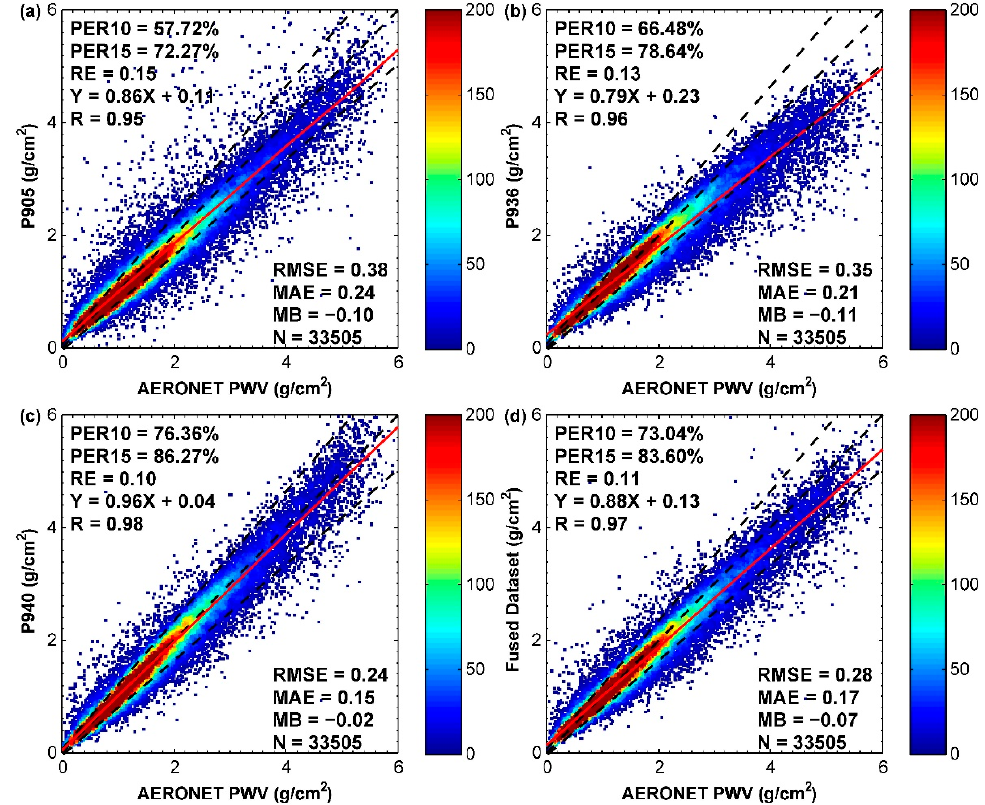
Figure 3. Scatter plots of matching results between AERONET PWV data and four MERSI-2 PWV datasets: ( a ) MERSI-2 P905 PWV dataset; ( b ) MERSI-2 P936 PWV dataset; ( c ) MERSI-2 P940 PWV dataset; ( d ) fused MERSI-2 PWV dataset. The dashed line in the middle is the 1-1 line. The dashed lines on both sides are the envelope of PER15. The red line is the linear regression line. The color of each point represents the density of the point where the point is located.